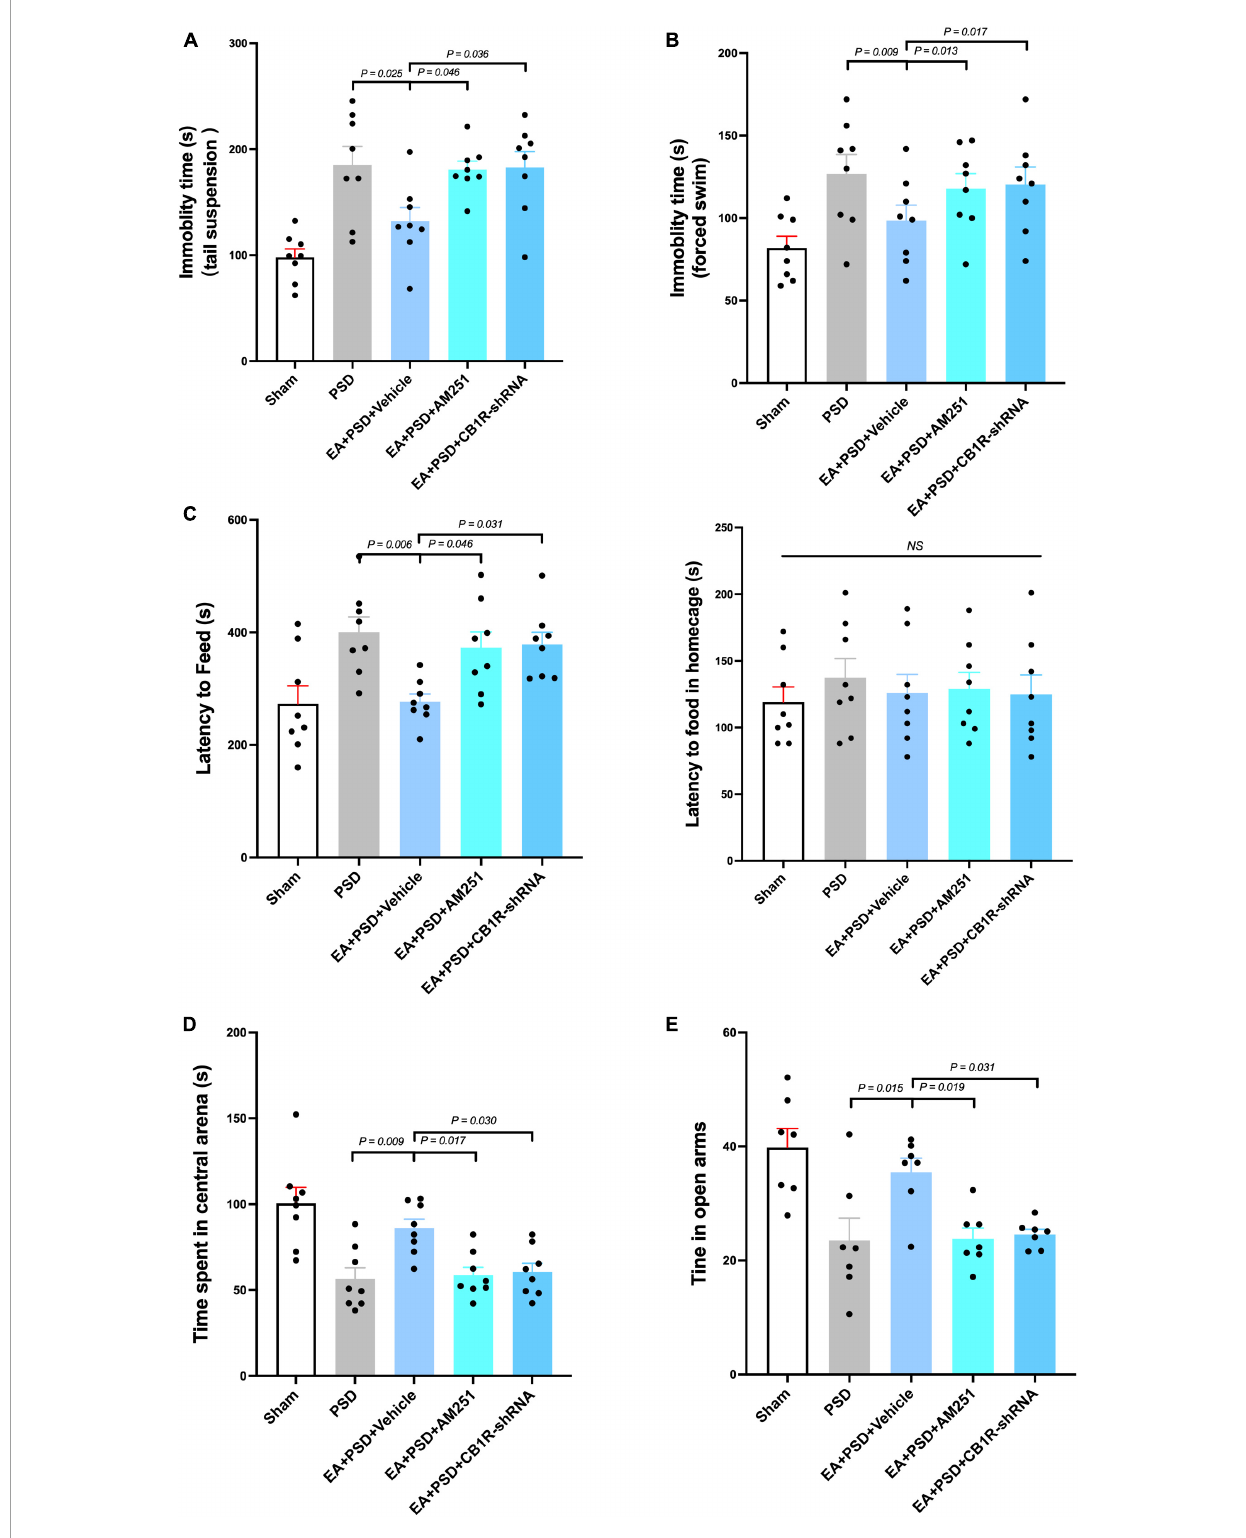
FIGURE5 The anti-depressive like behavior produced by EA treatment was abolished by the supplementation of AM251 and CB1R-shRNA. (A) Mutant of CB1R by CB1R antagonist AM251 or CB1R-shRNA prevented the decrease in immobility in TST induced by EA treatment. (B) CB1R deletion reversed the reduction in immobility in FST produced by EA treatment. (C) EA treatment significantly reduced the latency to feed in the novel environment in NSFT, whereas this decreased was reversed by CB1R deficiency. Neither EA nor AM251, CB1R-shRNA altered the latency to feed of mice in their home cages. (D) CB1R knockdown significantly abolished the effect of EA treatment on the increase of time spent in the center arena of the OFT. (E) In EPM test, EA treatment up-regulated the reduction of time spent in open arm produced by PSD, while CB1R silence prevented this up-regulation ( n = 8 per